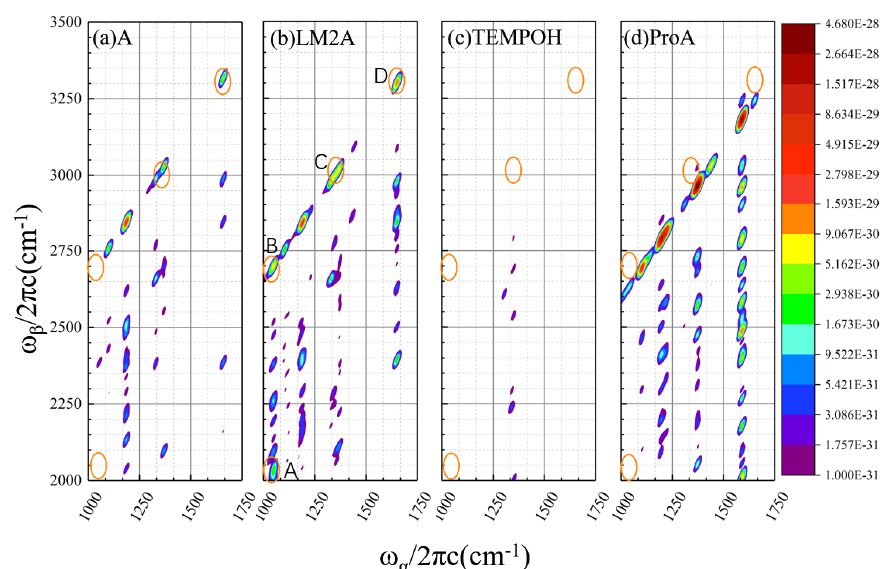
Figure 4. Calculated EVV-2DIR spectrum for ( a ) reactant A, ( b ) β -aminoxylated intermediate LM2A, ( c ) TEMPOH and ( d ) amino diene intermediate ProA in enamine reaction pathway. The figure is shown as a contour map with a logarithmic scale. The characteristic cross peaks in the intermediate LM2A are indicated by labels and orange circles.